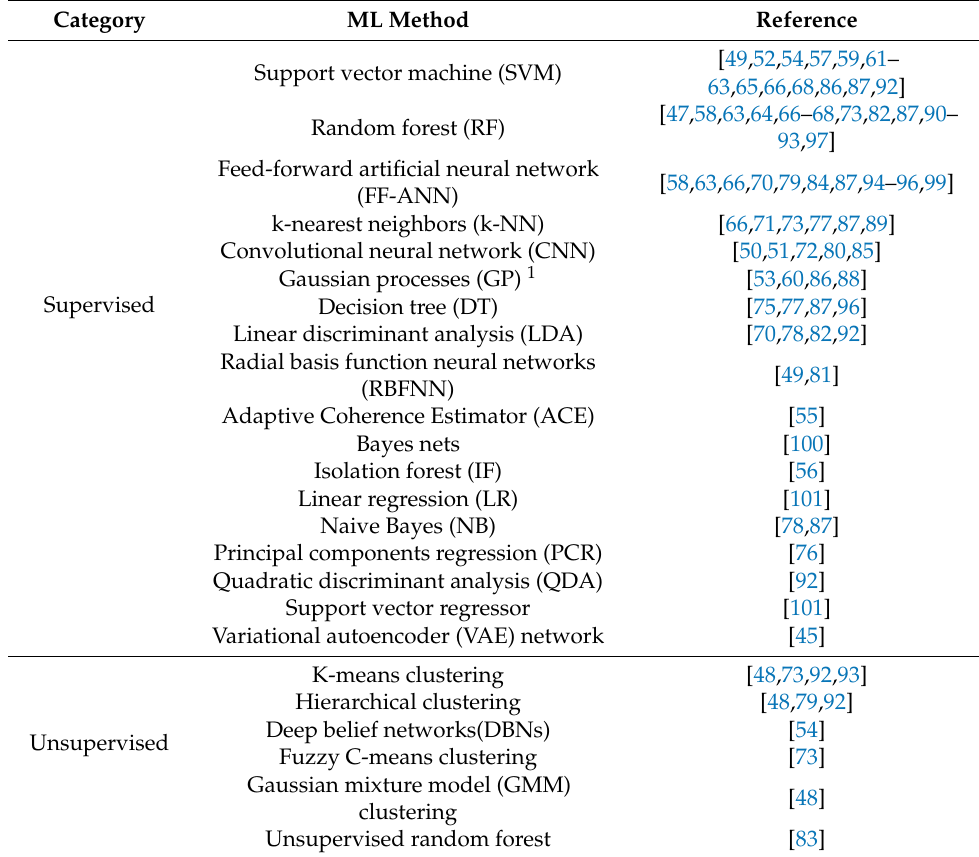
Table 2. ML models leveraged in the selected